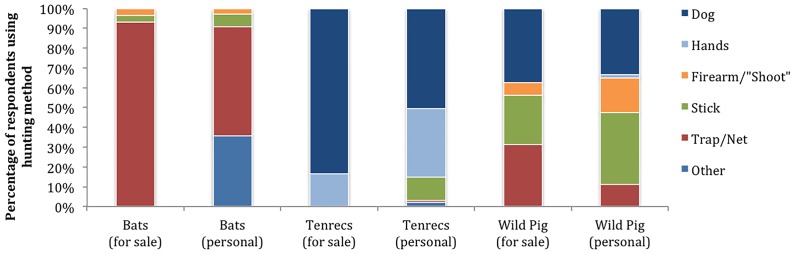
Comparison of hunting methods used to capture wild mammals for sale and for personal consumption (percentages).Individuals are replicates; data taken from meat consumption interviews. Hands = catching with hands by one or multiple people. Trap/Net = includes nets, cable traps, bait with traps. Spit Tube = a blow tube or a device to shoot darts. Stick = includes hitting animal with stick or spearing animal with stick. Individuals are replicates. Other = includes all other hunting methods (e.g. slingshots, fire, using a cross bow).